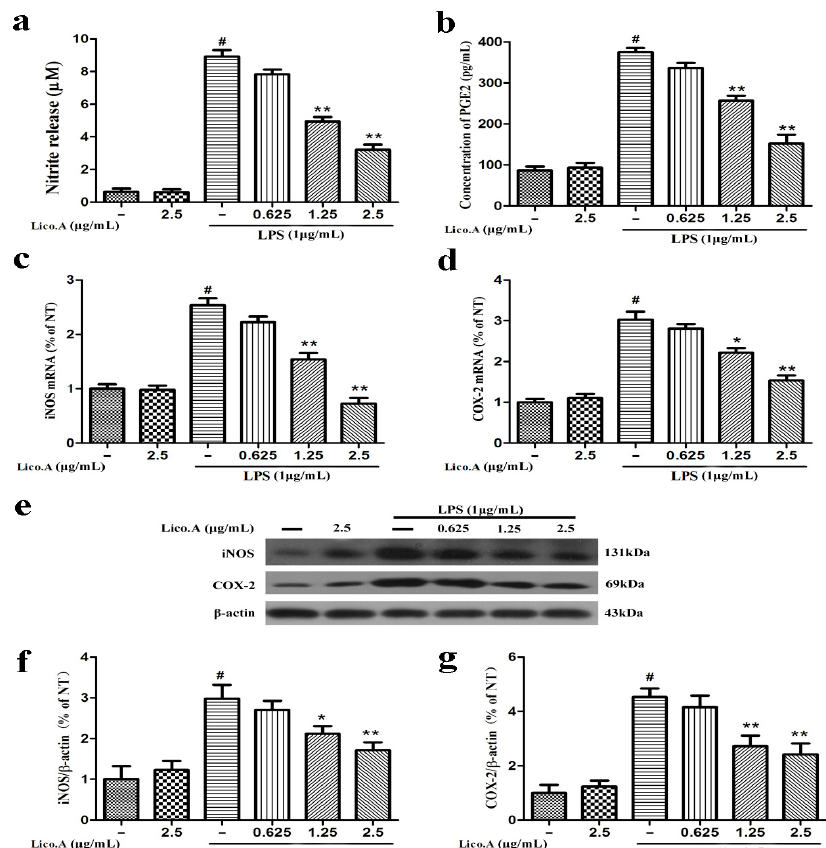
Figure 1. Licochalcone A (Lico.A) inhibits the production of nitric oxide (NO) and prostaglandin E2 (PGE2) and expression of iNOS and COX-2 in lipopolysaccharide (LPS)-stimulated BV-2 cells. ( a ) NO production was measured by Griess reagents; ( b ) The production of PGE2 in supernatant was analyzed by ELISA; ( c , d ) The mRNA levels of iNOS and COX-2 were measured by RT-PCR; ( f , g ) The protein levels of iNOS and COX-2 were analyzed by Western blot. All the experiments were repeated at least three times and similar results were observed. Values are mean ± SE (standard error), ( n = 5 samples/group). # p < 0.01 vs. NT group (cultured in medium alone); ** p < 0.01, * p < 0.05 vs. LPS group.